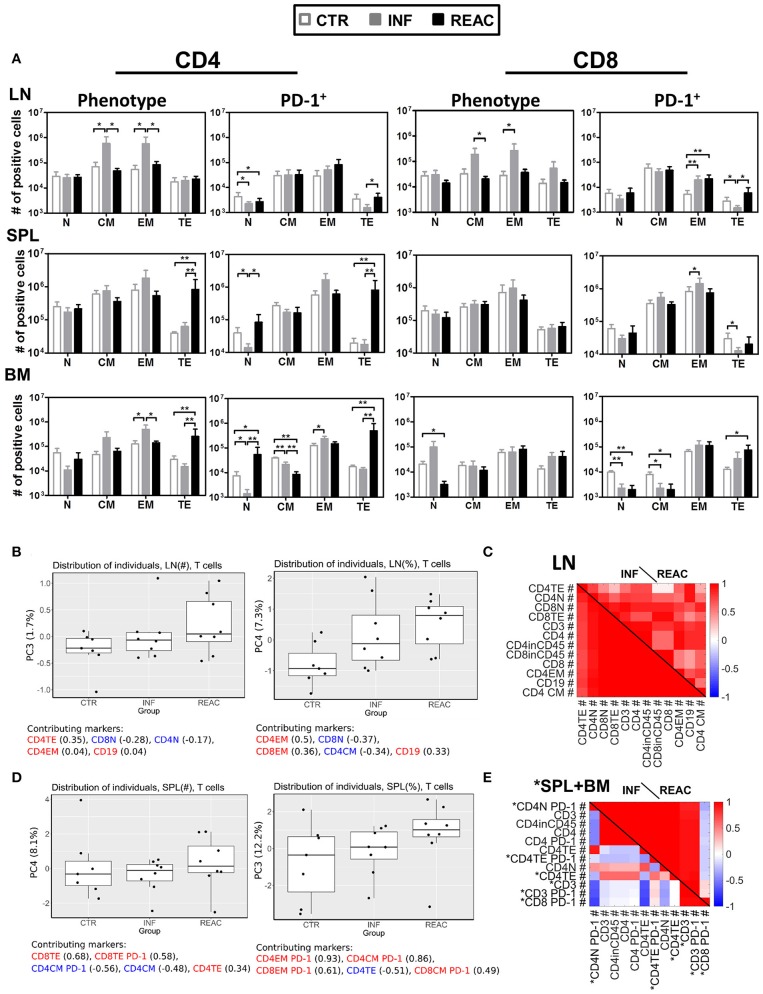
Differentiation of CD4+ and CD8+ T cell subsets after HCMV infections and reactivations and PCA analysis. (A) Total cell numbers (# of positive cells) are shown for CD4+ T cells (left) and CD8+ T cells (middle) for different subtypes (N, CM, EM, TE) and activation (PD-1+) (right) analyzed in CTR (white bars), INF (gray bars), or REAC (black bars) cohorts for LN, SPL, and BM. Reconstitutions included in the analysis are indicated (R1+R2: CTR n = 7, INF n = 8, REAC n = 8). Negative binomal-regression model was applied for statistical analysis (* < 0.05; ** < 0.01). (B,C) PCA analysis of T cell-associated markers with absolute numbers (#) was performed according to the materials and methods. Selected markers are sorted vertically (descending order) based on their maximum correlation with the first 3 principal components. Correlations between markers in (B) LN, and (C) combined measurements from SPL (blue) and BM (black) are shown for different groups of mice. (B,C) PCA performed with T cell-associated markers including absolute numbers (#) and frequencies (%) in LN was performed according to the materials and methods. (B) Distribution of the individual measurements in each group is shown for PC3 and PC4 as box-plots. The percentage of the data variation explained by each PC is given in the y-axis. The top 5 (ordered) markers contributing to the composition of each PC and their correlation with each PC are given. Positive and negative values of correlation coefficient are coded with red and blue texts, respectively. (C) Markers with highest maximum correlation with the first 3 PCs are selected and ordered vertically. Correlation between these markers is shown for INF and REAC groups as heat-maps. (D,E) The same analysis as in (B,C) was performed with T-cell associated absolute (#) and frequency (%) measurements in SPL (D) and using a combined data set of absolute numbers (#) of T-cell associated markers in SPL (marked with asterisk) and BM (E).